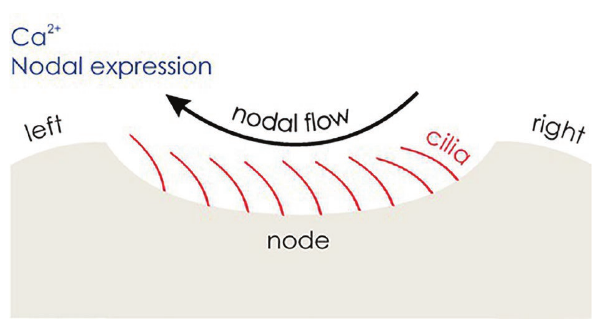
FIGURE 3 | The development of visceral asymmetries. Motile cilia (red) induce a leftward nodal flow, which is transduced into stronger left-sided Ca 2+ signaling and Nodal expression, triggering the Nodal signaling pathway in the left lateral plate mesoderm